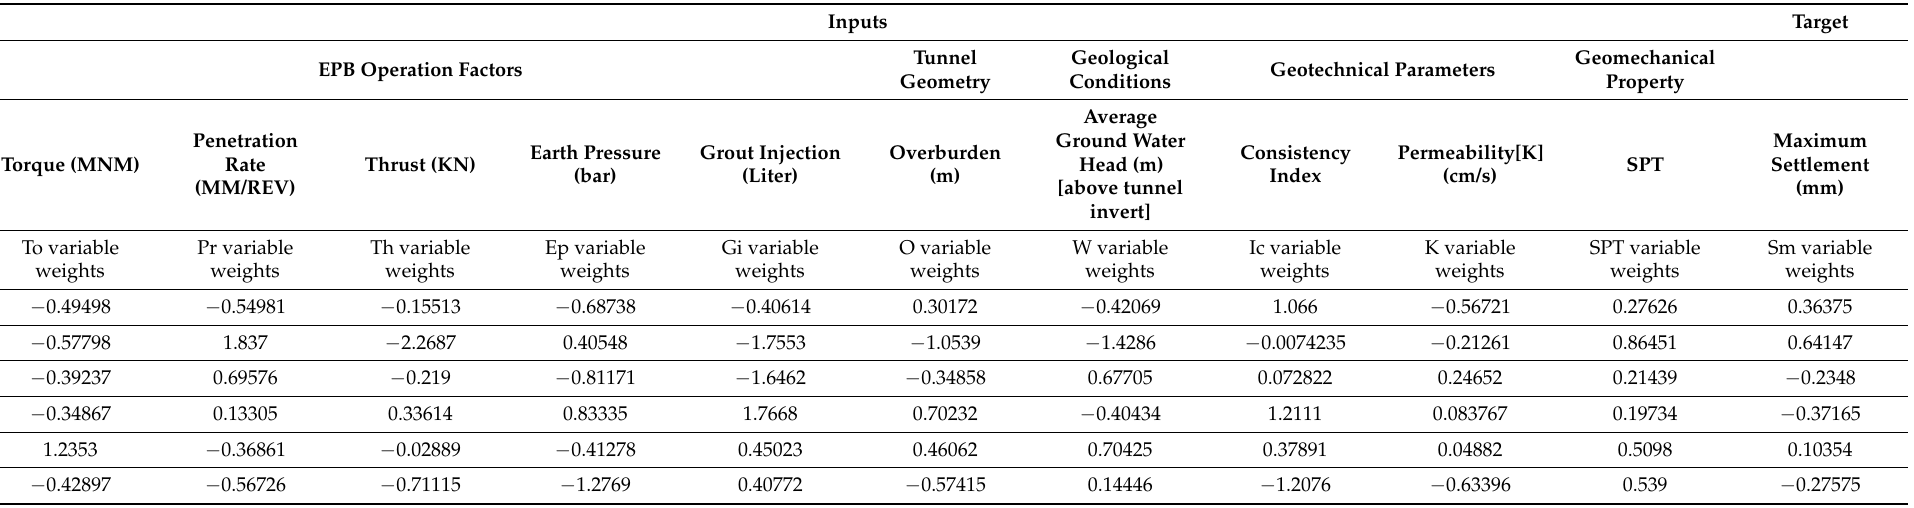
Table 3. Weights derived from an idealized neural network (NN